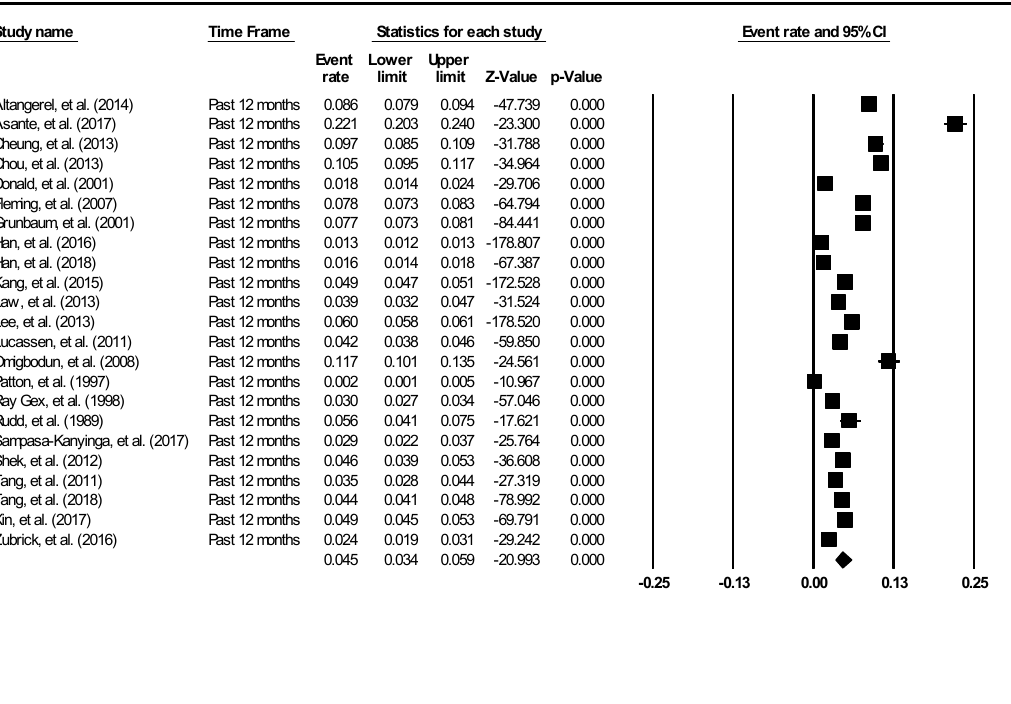
Figure 3. Forest plot of the aggregate 12-month prevalence of suicide attempts.